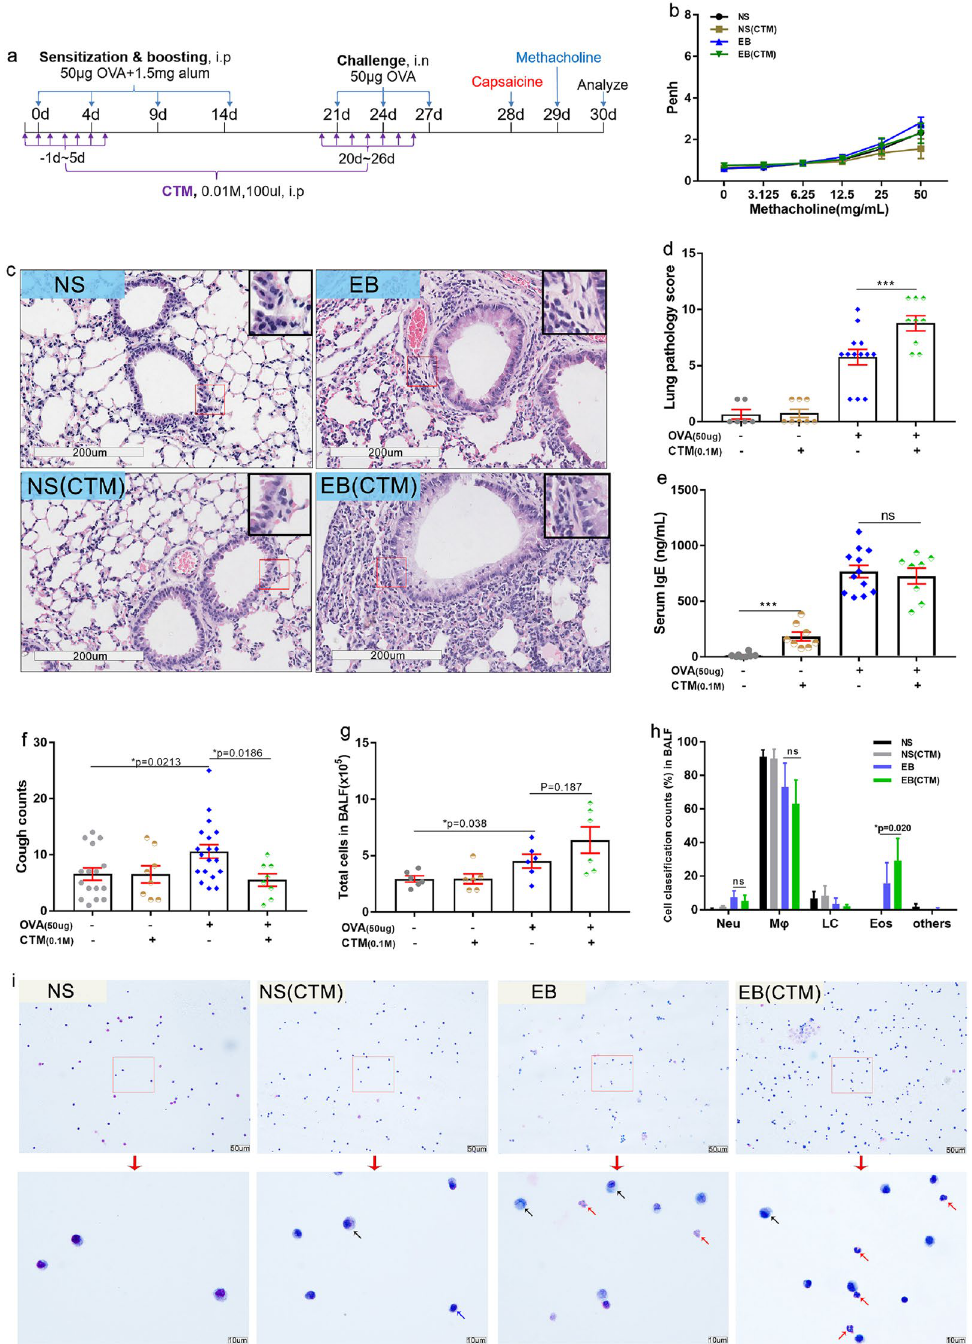
Figure 6. Inhibition of TG2 activity by cystamine treatment lowers the extent of inflammation in the lung and decreases the cough frequency in EB mice. TG2 activity in C57BL/6 mice was inhibited by intraperitoneal injection of CTM (0.01 M, 100 μL each mice) once daily for seven days from one day before the first intraperitoneal OVA sensitization and the first OVA intranasal challenge respectively. ( b ) Penh was evaluated in mice with or without CTM treatment. ( c , d ) Lung pathology score of C57BL/6 mice lung sections with or without CTM treatment was evaluated under hematoxylin and eosin staining. Representative photographs (200 × magnification) are shown; insets in ( c ) show eosinophil (red) infiltration around terminal bronchioles. Lung pathology score is displayed in ( d ). IgE concentration in indicated mice sera is represented in (e) . ( f ) The frequency of cough in NS or EB model usingC57BL/6 mice with or without CTM treatment was automatically detected using the Finepointe software and recorded. Total cells in the BALF ( g ), differential cells percentage ( h ) and representative photographs of BALF cells’ staining ( i ) were exhibited. (up, 200 × ; down, 1000 × magnification). Arrows’ colors represented different type of cells (black-monocytes and macrophages; blue-lymphocytes, red-eosinophils). (n ≥ 6. * P ≤ 0.05; *** P < 0.001; ns, no significance). The scale is indicated on the panel by the length of the box around the size in